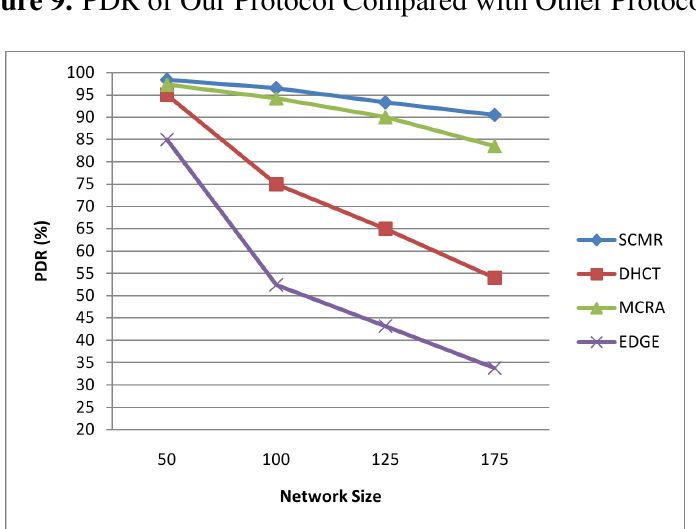
Figure 9. PDR of Our Protocol Compared with Other